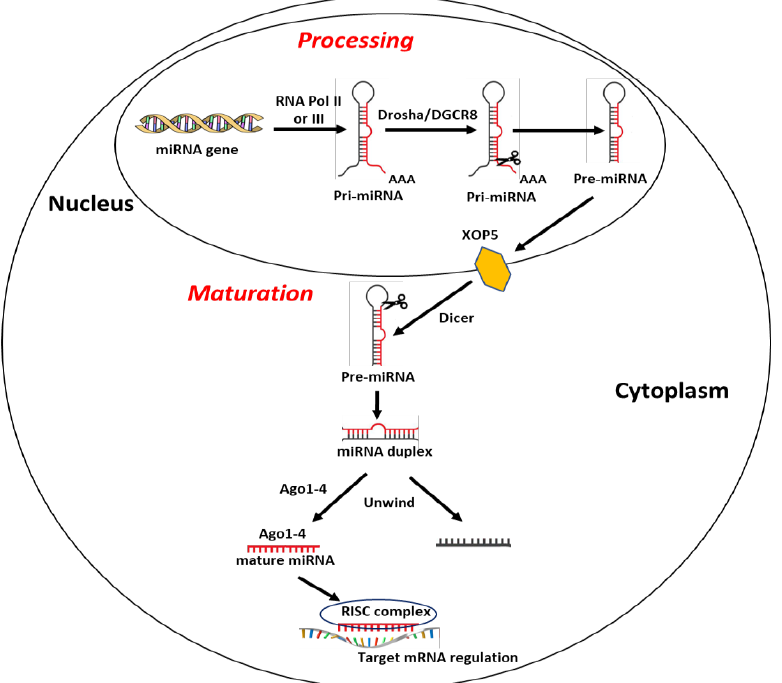
Figure 1. Schematic representation of miRNA synthesis, as explained in the text. Abbreviations: RNA Pol II or III: RNA Polimerase II or III; Drosha: DGCR8: DiGeorge syndrome critical region gene 8; XOP5: Exportin 5; RISC complex: RNA-induced silencing complex.